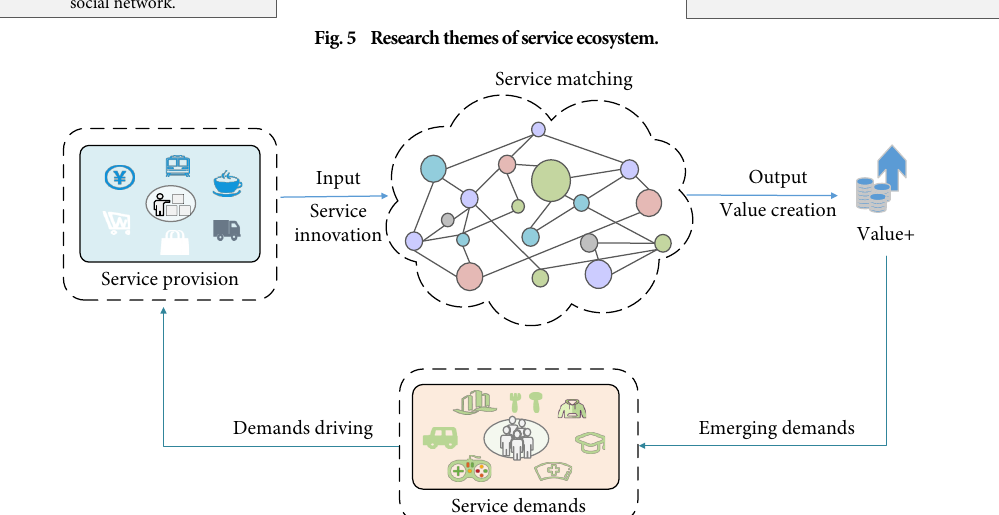
Fig. 5 Research themes of service ecosystem.